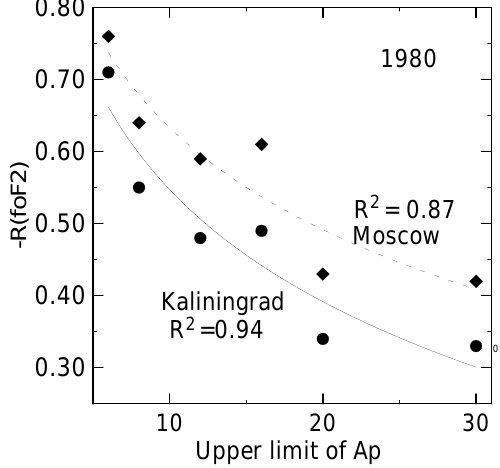
Fig. 2. Variations of R ( fo F2) with the limiting value of the A p index for two